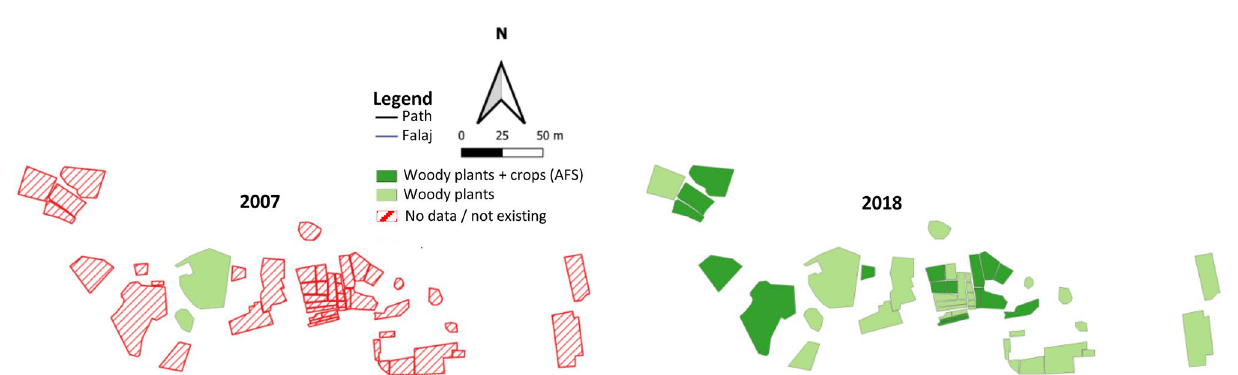
Figure 9. Landuse map of the oasis Masayrat ar Ruwajah (1030 m a.s.l.) in Wadi Muaydin (Al Jabal Al Akhdar, Oman) in 2007 and 2018.